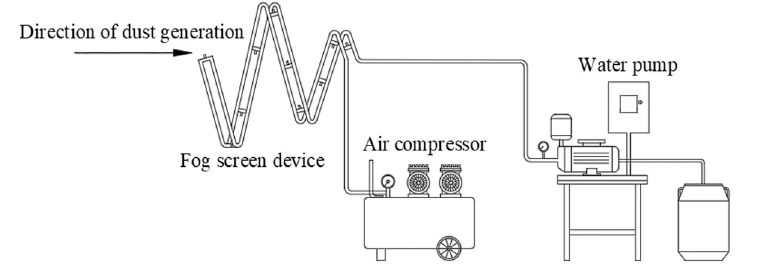
Fig 11. Design of multilayer vortex fog curtain test